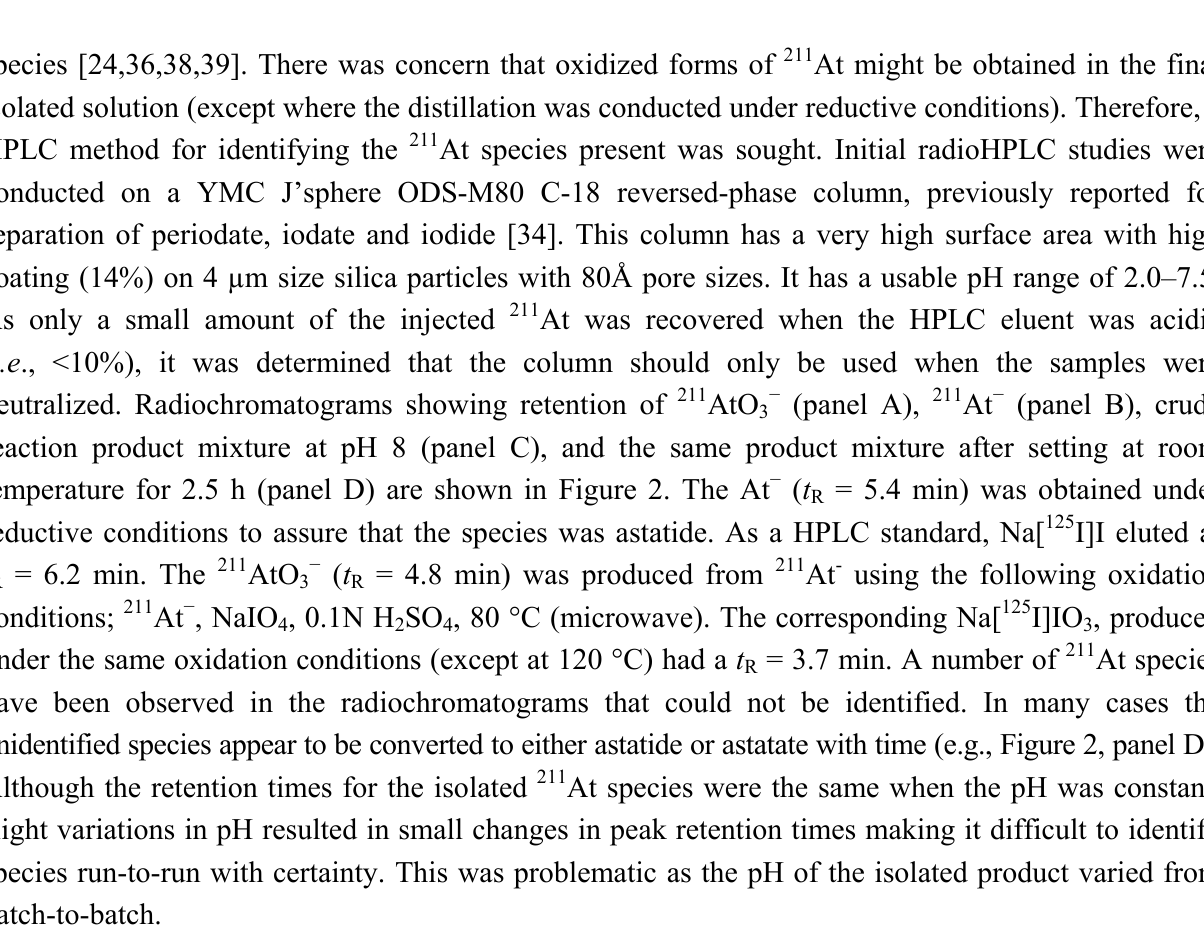
Figure 2. Examples of radiochromatograms obtained by eluting 211 At solutions on a YMC J’Sphere ODS-M80 column using isocratic conditions eluting with 1:1 CH